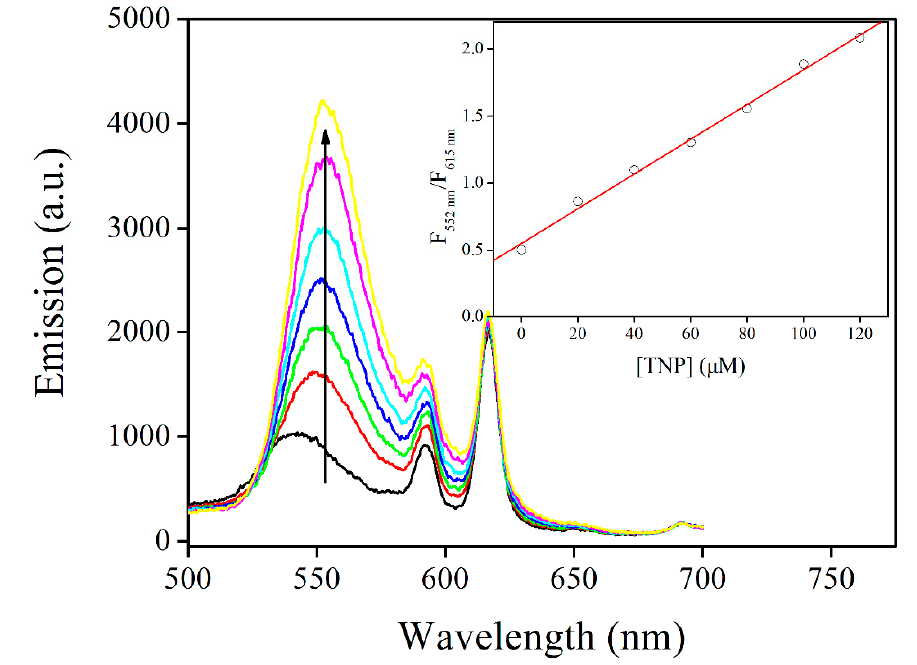
Figure 7. Emission spectra of RS6h@EuBTC suspension in ethanol (0.1 mg / mL) under TNP concentrations from 0 to 120 µ M (interval = 20 µ M). Inset: F 552 nm / F 615 nm against TNP concentration. Mean value of three test cycles was used for each data point.